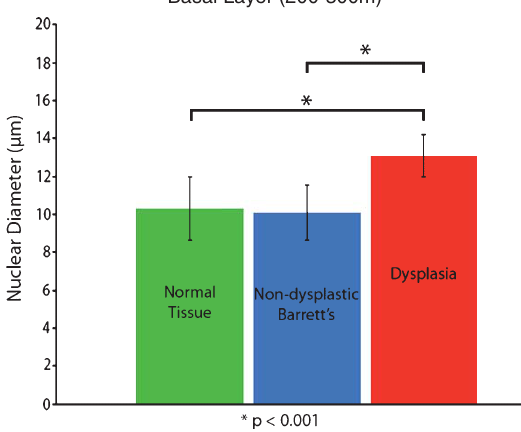
Fig. 6. Comparison of a/LCI measurements of nuclear morphology from in vivo study of Barrett’s esophagus epithelium. A statistically significant increase ( p <0.001) is seen for sites identified as dys- plastic by pathological evaluation of biopsy samples compared with normal tissue types and non-dysplastic Barrett’s esophagus tissue. Adapted from [36].